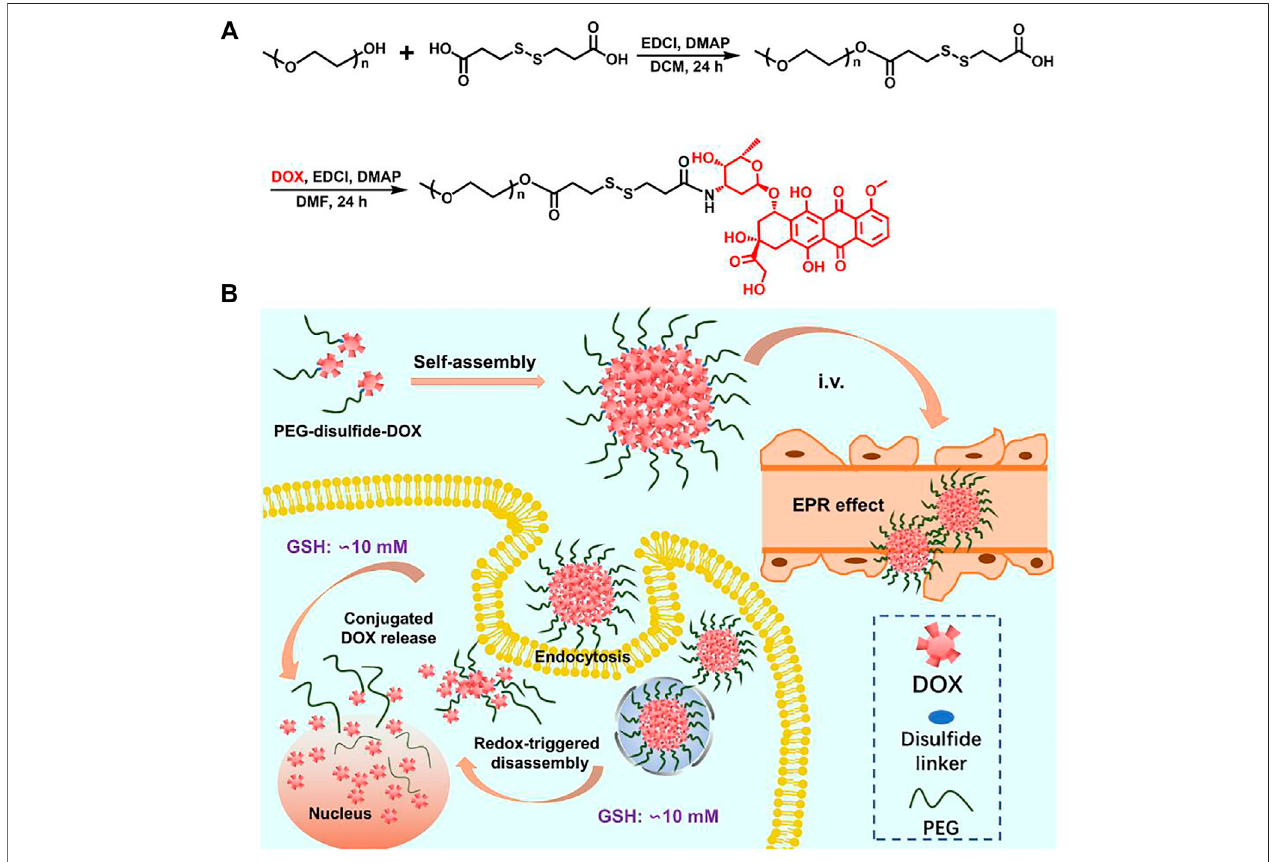
FIGURE 1 | Synthetic scheme of the PEG – disul fi de – DOX polymer and micelles with reduction-sensitive behavior for intracellular drug release.